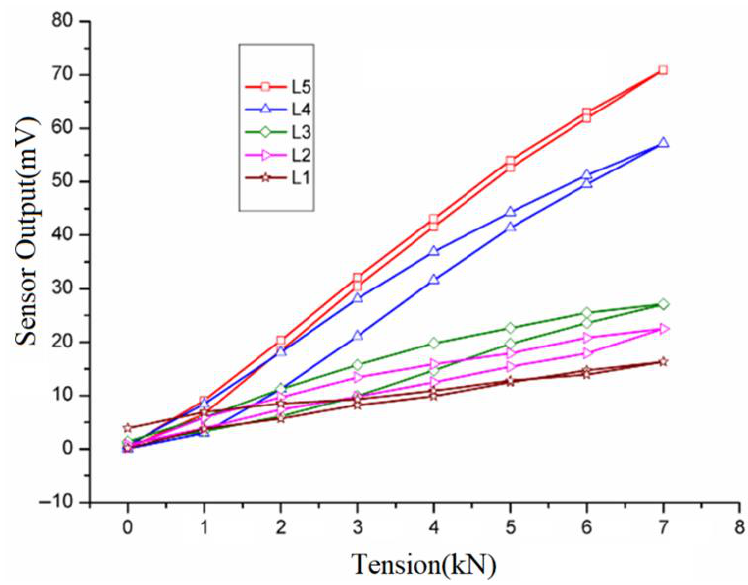
Figure 14. Sense signal curve with gaps variation of the excitation sensor.